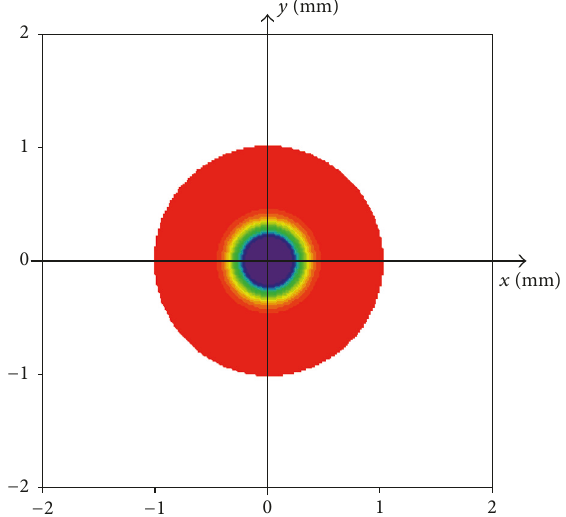
Figure 8: Two-dimensional distribution of the function 𝑝(𝑧(𝑥,𝑦)) .